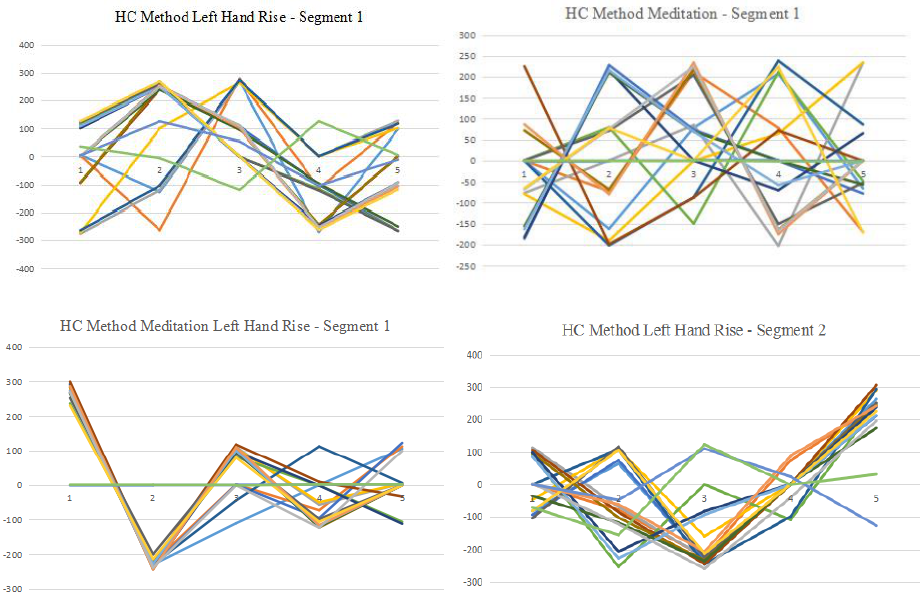
Figure 7. EEG clustering results based on three statuses (left-hand rise, meditation, left-hand rise mediation; results for 5 clusters, PDA segment 1). Electronics 2020 , 9 , x FOR PEER REVIEW 14 of 18